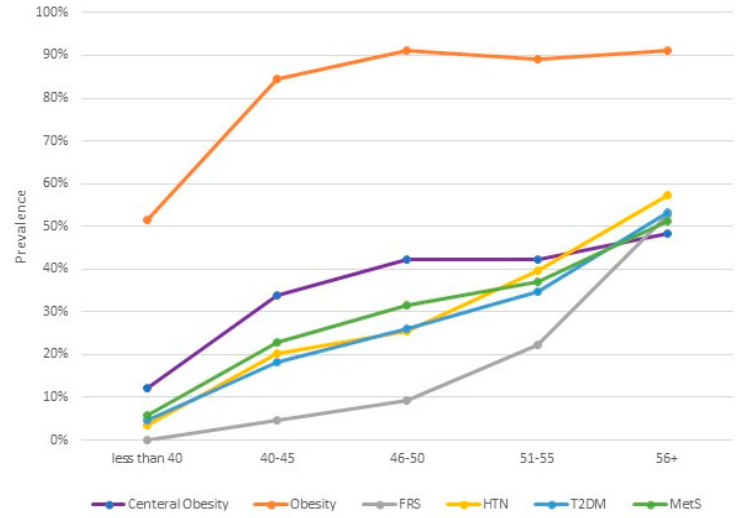
Figure 1. Prevalence of different cardiometabolic risks among the studied sample according to their age. Obesity: Body Mass index more than 25 kg/m 2 , FRS: High/intermediate Framingham Coronary Heart Risk Score, HTN: Hypertension, T2DM: Type 2 Diabetes Mellites, MetS: Metabolic Syndrome Score.